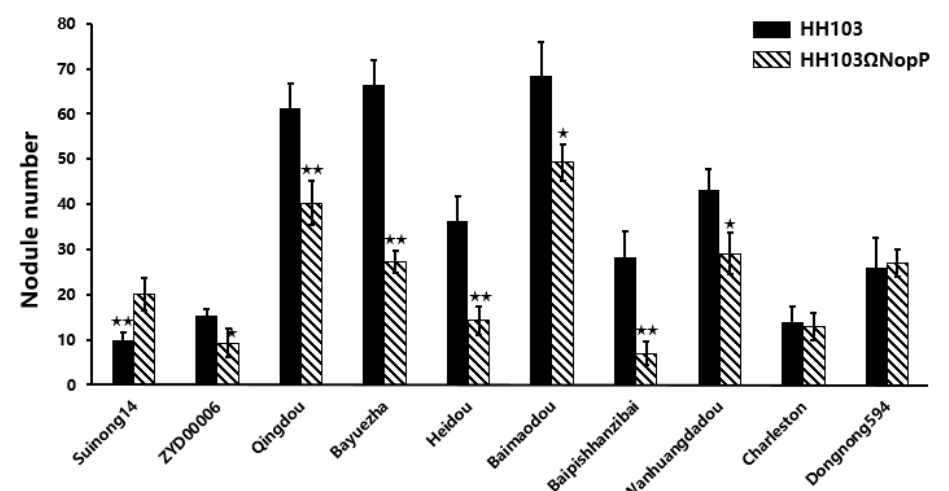
Figure 1. Nodule phenotype of soybean germplasm after inoculation with Ensifer fredii HH103 and Ensifer fredii HH103 Ω NopP. Nodulation tests were performed three times; t -test was performed comparing the NopP mutant to the wild type strain; when significant (0.01 ≤ p ≤ 0.05), an asterisk is shown, ** indicate p ≤ 0.01.